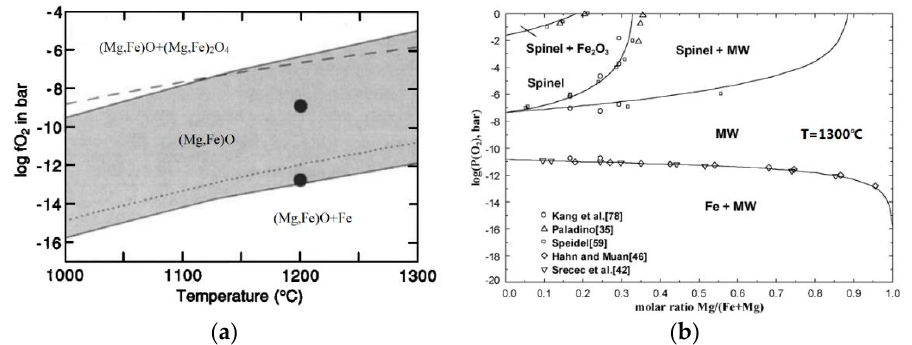
Figure 1. ( a ) Phase diagram of ferropericlase (Mg 0.8 ,Fe 0.2 ) O with different temperatures and oxygen fugacity (McCammon (1998)); ( b ) phase diagram of ferrite with different temperatures, oxygen fugacity, and magnesium-to-iron ratio (Jung, Decterov, and Pelton (2004) [42]).